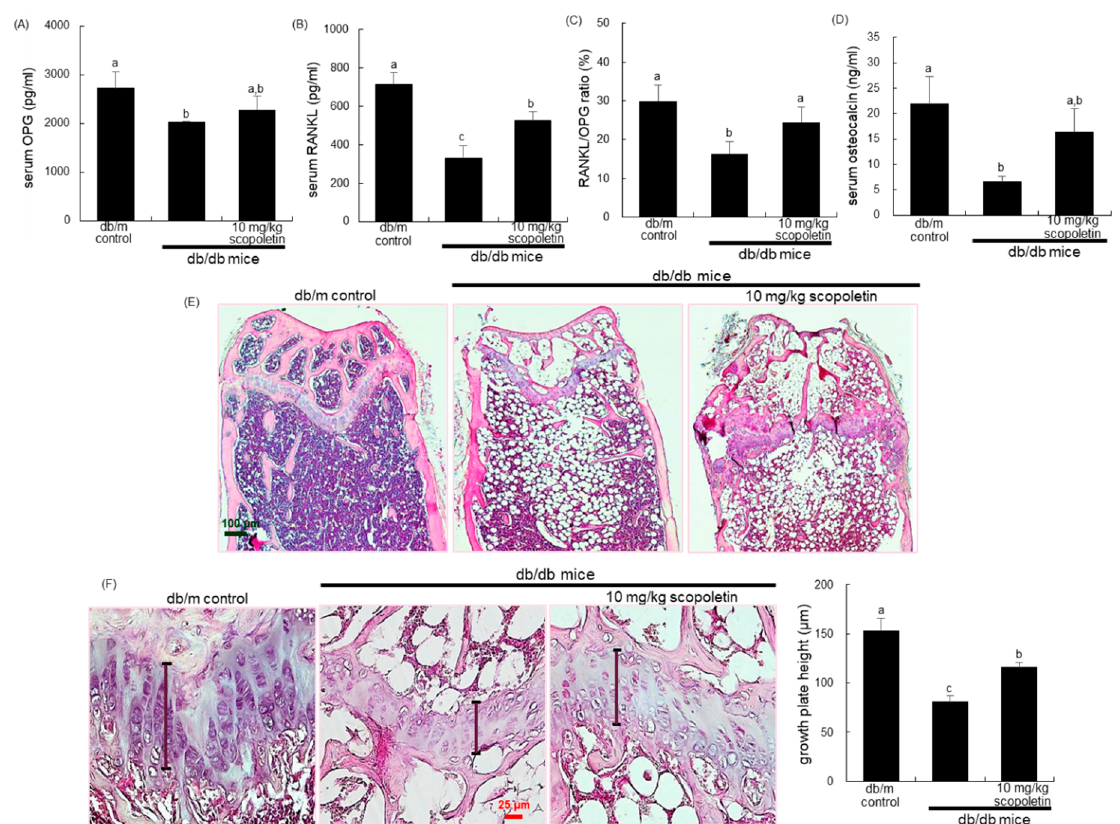
Figure 4. Effects of scopoletin on secretion of receptor activator of nuclear factor- κ B-ligand (RANKL, A ) and osteoprotegerin (OPG, B ), RANKL/OPG ratio ( C ), plasma osteocalcin level ( D ), histology of trabecular bone ( E ), and epiphyseal plate thickness of growing bone ( F ). The db/db mice were orally administrated with 10 mg/kg scopoletin daily for 10 weeks. The serum levels of RANKL, OPG, and osteocalcin were determined using ELISA kits ( A – D ). For the observation of trabecular bone and epiphyseal plate, longitudinal sections of femoral bone tissues were H&E-stained ( E , F ). Images were visualized under light microscopy (four separate experiments). Scale bar = 25 and 100 μ m. The values in bar graphs (mean ± SEM, n = 4) not sharing a small letter are different at p < 0.05.